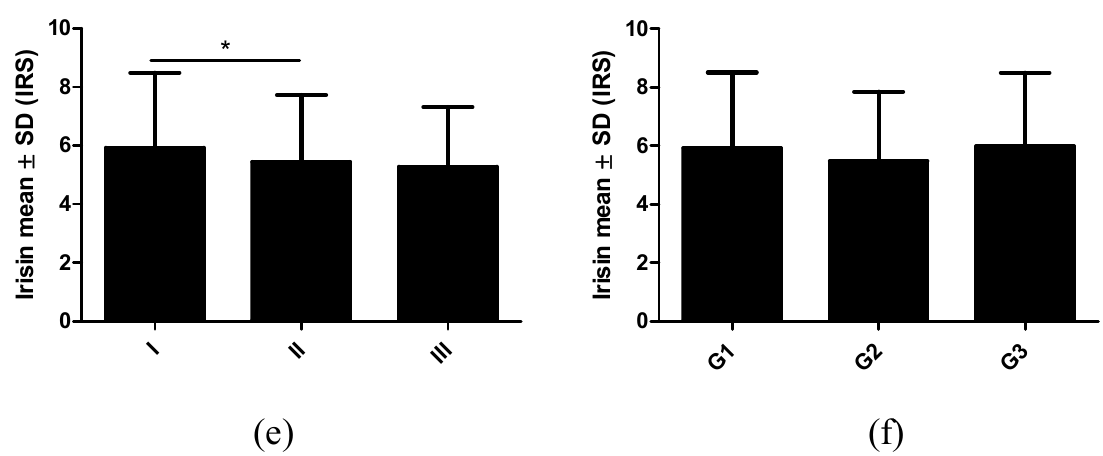
Figure 3. Comparison of irisin expression levels using immunohistochemistry (IHC) in breast cancer (BC) patients and control tissues ( a ) according to the lymph node status ( b ), tumor size ( c , d ), tumor stage ( e ), and malignancy grade ( f ). * p < 0.05, *** p < 0.001, **** p < 0.0001.